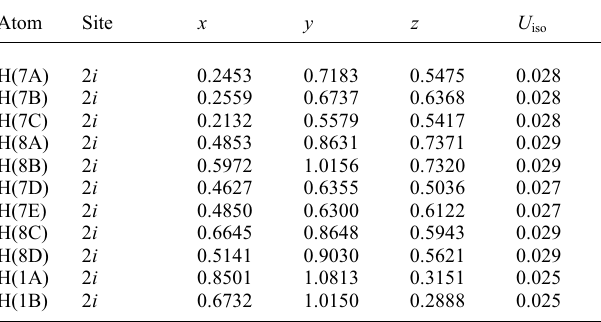
Table 2. Atomic coordinates and displacement parameters (in Å 2 ) .